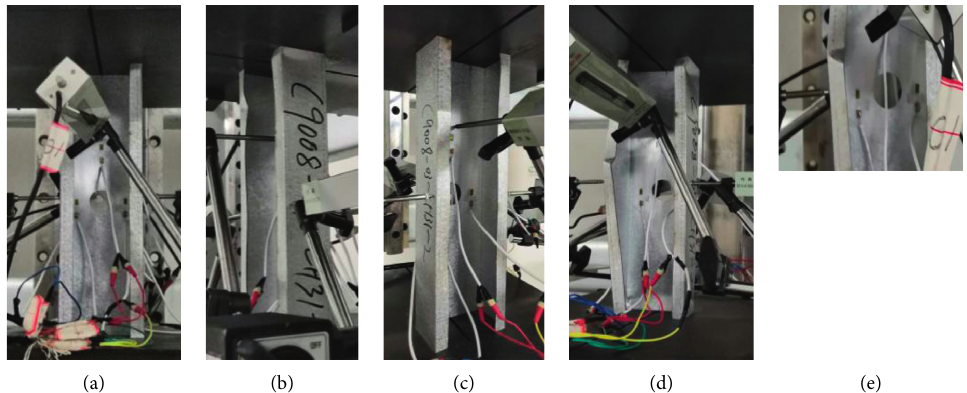
Figure 9: Buckling mode of specimen C9008-03-CH3-1. (a) Local buckling in the web. (b) Local buckling in the flange. (c) Local buckling in the lip. (d) Plastic crush. (e) Local buckling including holes.